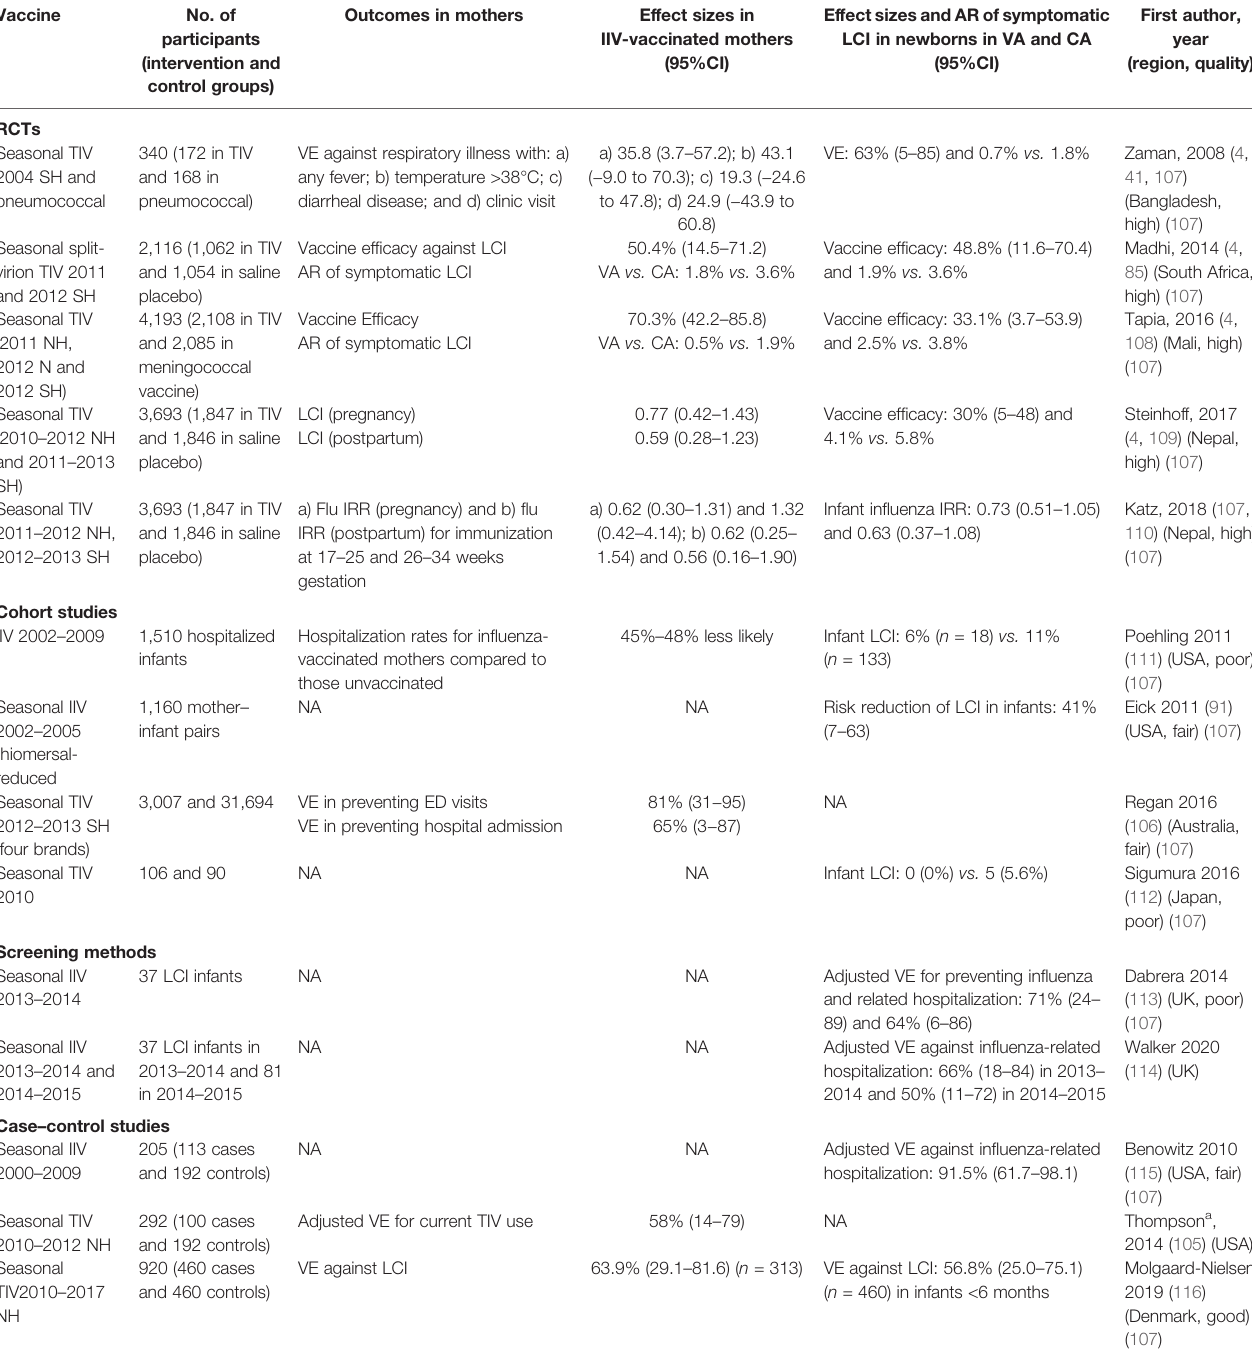
TABLE 1 | Vaccine ef fi cacy and effectiveness of in fl uenza vaccination in healthy pregnant women.